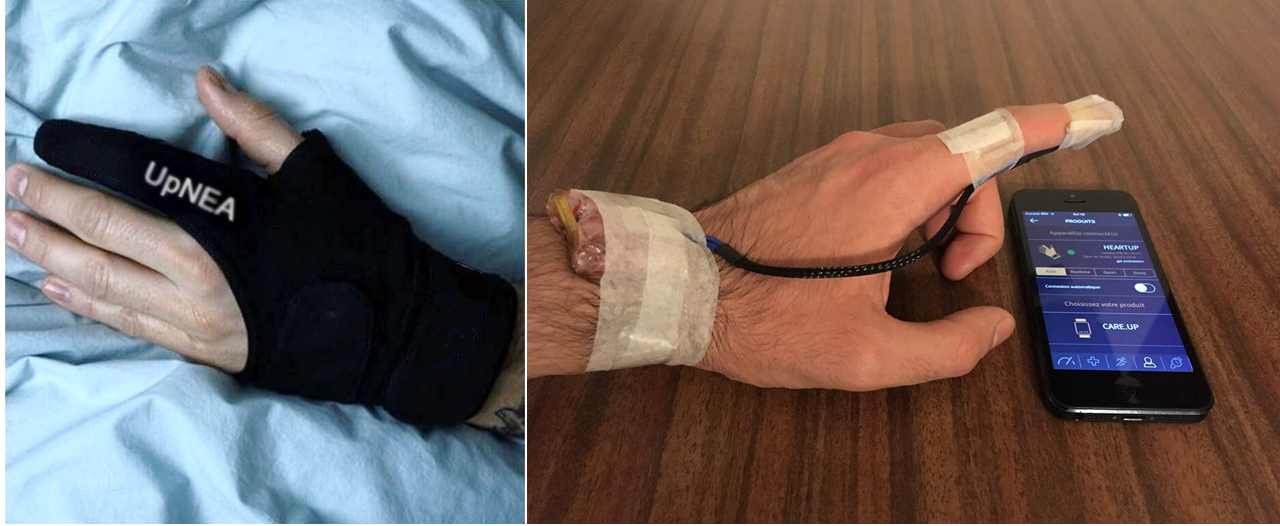
Figure 1. The UpNEA device and its